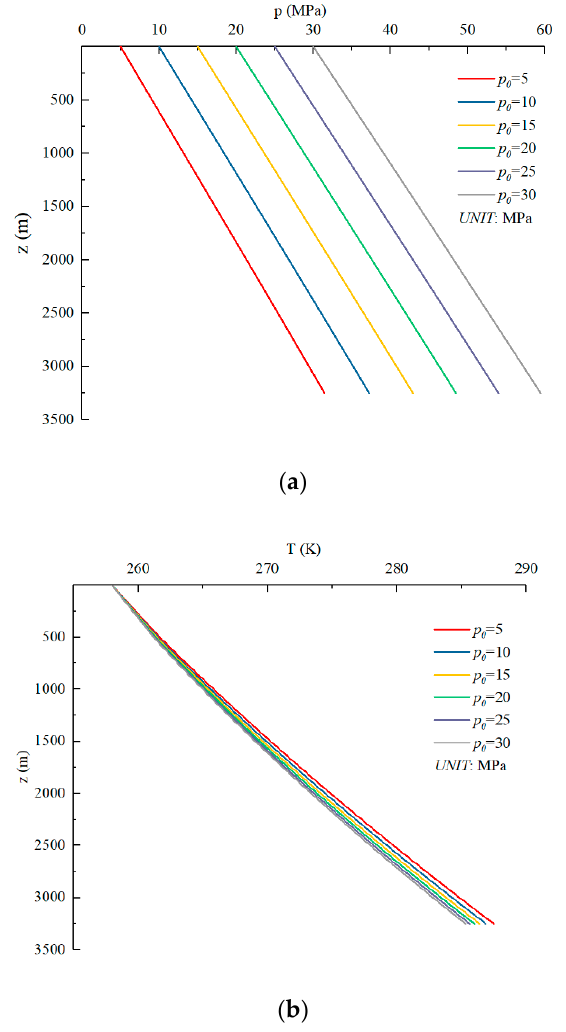
Figure 12. E ff ect of injection pressure: ( a ) CO 2 pressure profile; ( b ) CO 2 temperature Figure 12. Effect of injection pressure: ( a ) CO 2 pressure profile; ( b ) CO 2 temperature profile.